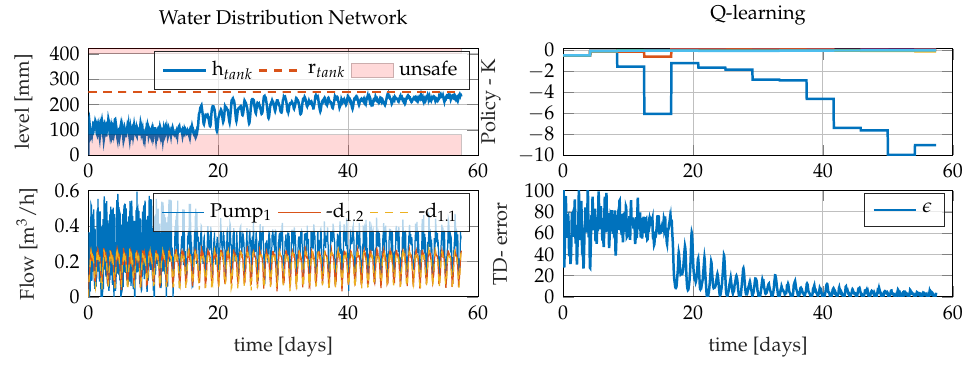
Figure 16. Graphs of the experimental results with RL control applied to Bjerringbro’s study case [42].